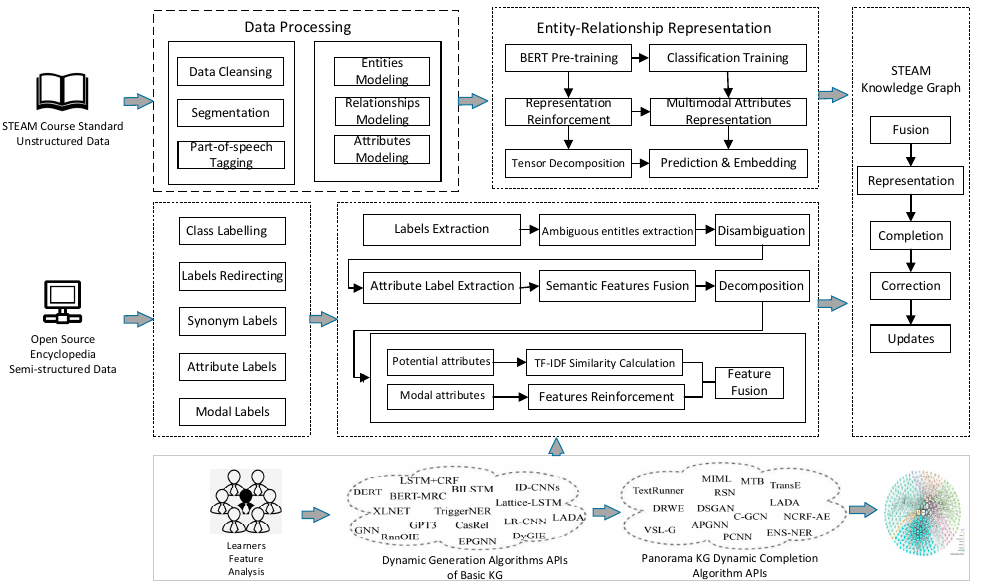
Figure 1. A dynamic generation framework of STEAM knowledge graphs.